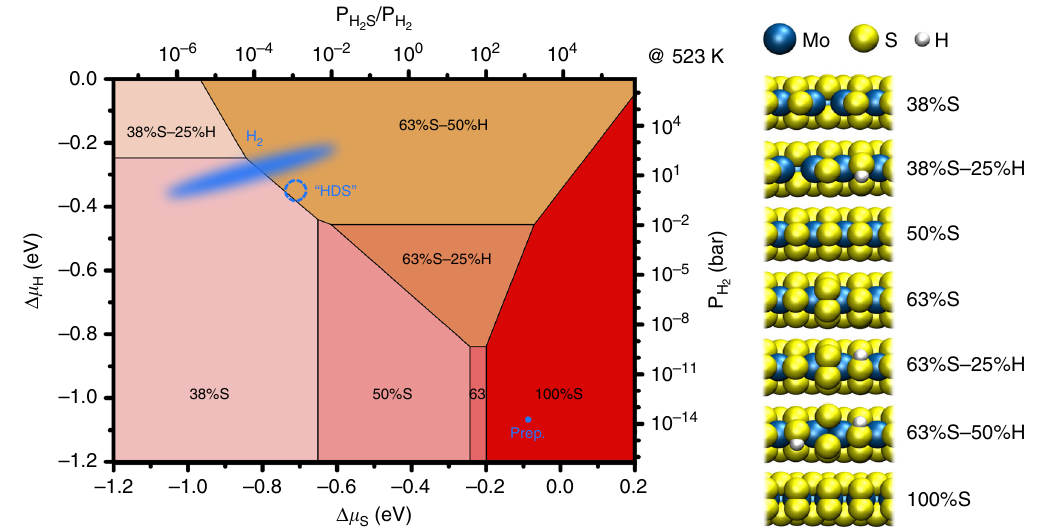
Fig. 3 Ab initio thermodynamics phase diagram of the MoS 2 edge structures in H 2 /H 2 S mixtures for Au-supported MoS 2 . On the axes, Δμ S and Δμ H designate the entropic parts of the chemical potentials of S and H atoms in the gas phase, respectively. These are directly related to the temperature, the H 2 S pressure, and the H 2 pressure (see Methods section). The experimental conditions during catalyst preparation, in 1 bar hydrogen (assuming 1 ppm H 2 S contamination), and during HDS (naïve approximation) are indicated in blue. The ball models represent side views of the structures present in the phase diagram. Note that the edges are periodic in the left-right